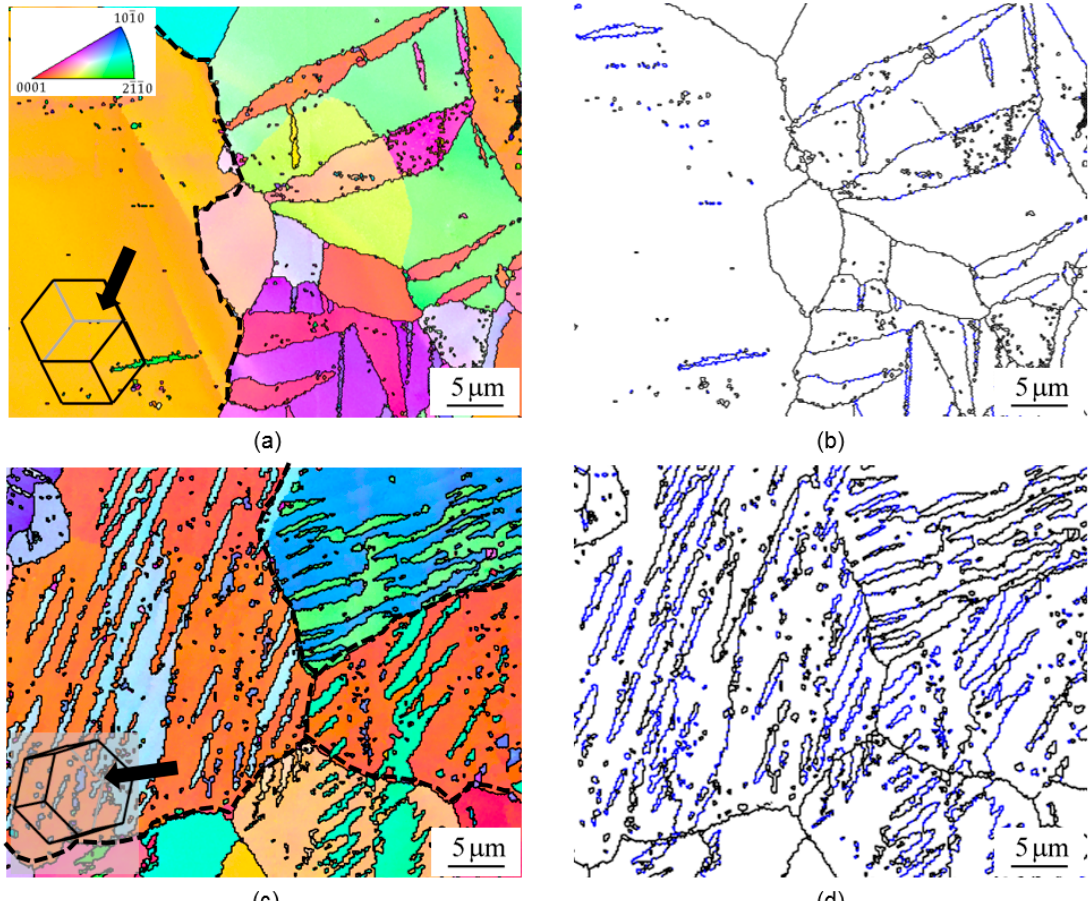
Figure 2. Inversed pole figure (IPF) maps of the deformed sample in the ( a ) center and ( c ) top regions. Grain boundary (GB) maps of the deformed sample in the ( b ) center and ( d ) top regions at the early stage of AR deformation. The interfaces with black and blue colors represent grain and twin boundaries, respectively.